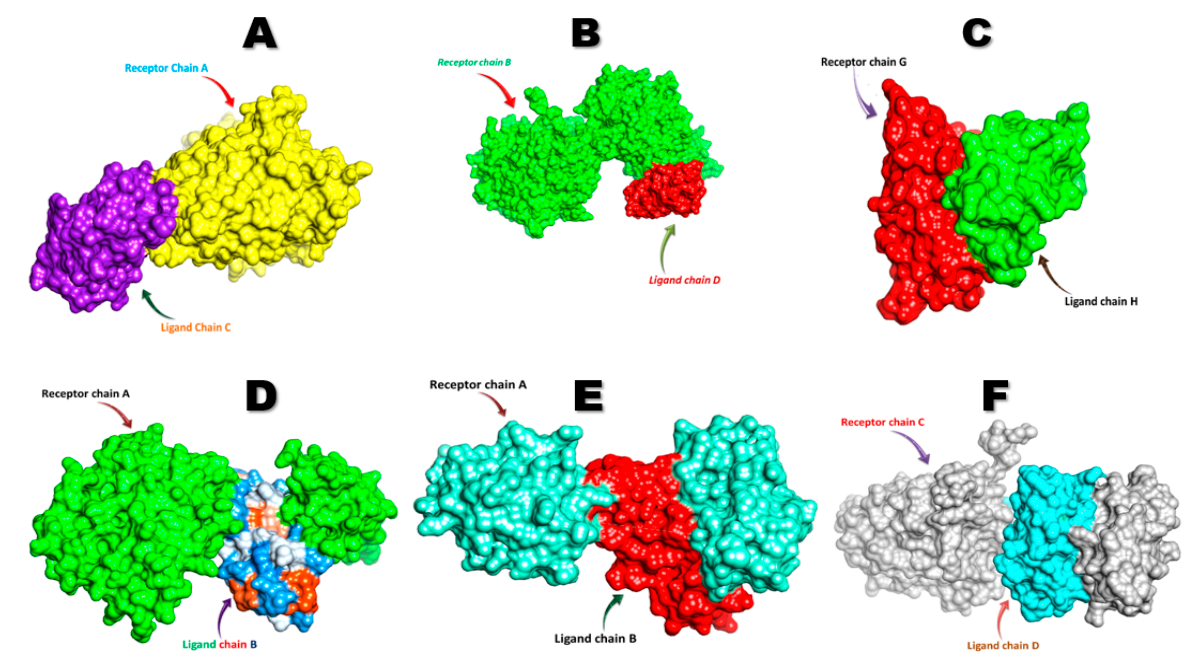
Figure 5. The superimposition of FNDC5 or irisin (ligand) and the receptors ( A ) Androgen ( B ) DDB1 and CUL4 associated factor 6 ( C ) Estrogen-related receptor β ( D ) Estrogen-related receptor γ ( E ) Krüppel-like factor 15 ( F ) Nuclear receptor subfamily 3 group C member 1.